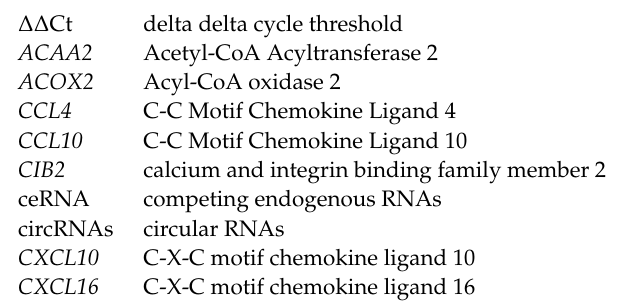
quencing; Table S3: Differentially expressed RNA statistics; Table S4: PTGs of Differentially expressed RNA; Table S5: MRNA, miRNA, circRNA-GO&KEGG analysis; Table S6: LncRNA GO&KEGG; Table S7: QTL mapping analysis on DERs; and Table S8: Gene co-expression